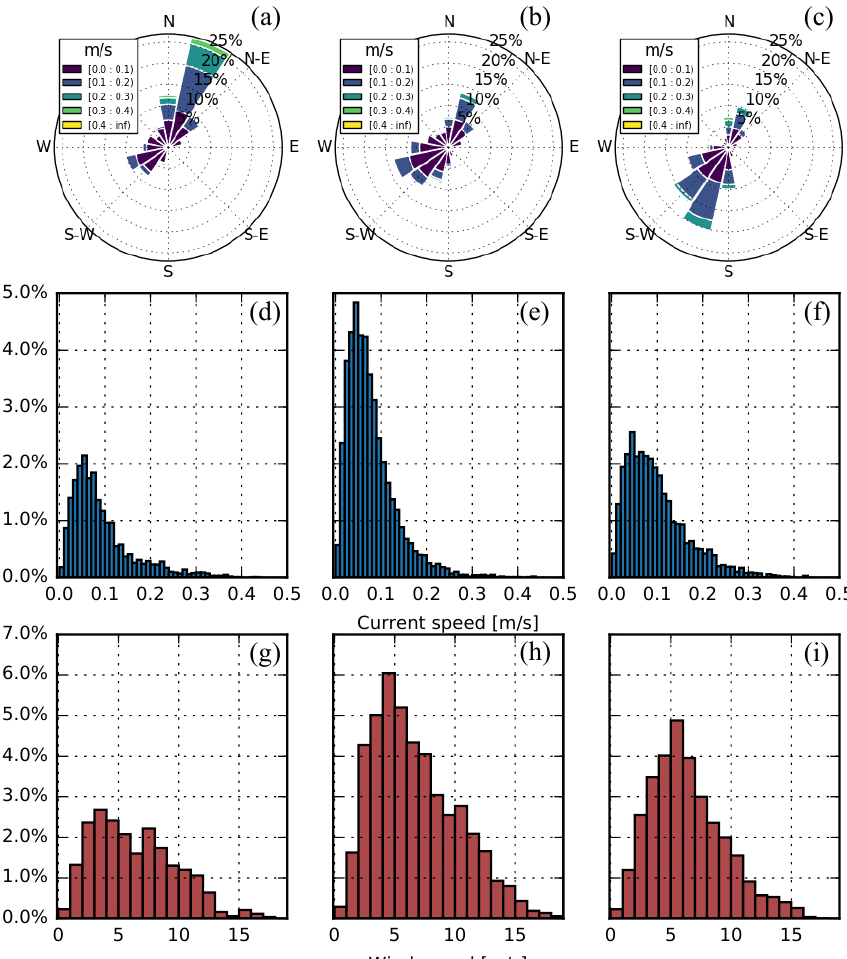
Figure 5. Current roses ( a – c ), histograms of the current speed ( d – f ) and histograms of the wind speed ( g – i ) for the S ( left panels ), W ( middle panels ) and N ( right panels ) sectors. Definition of sectors are shown in Figure 4. Percentages in the histograms represent the amount of currents and winds from a certain magnitude range from shown sector compared to the amount of measurements from the whole dataset. Only currents measured at 5 m depth are